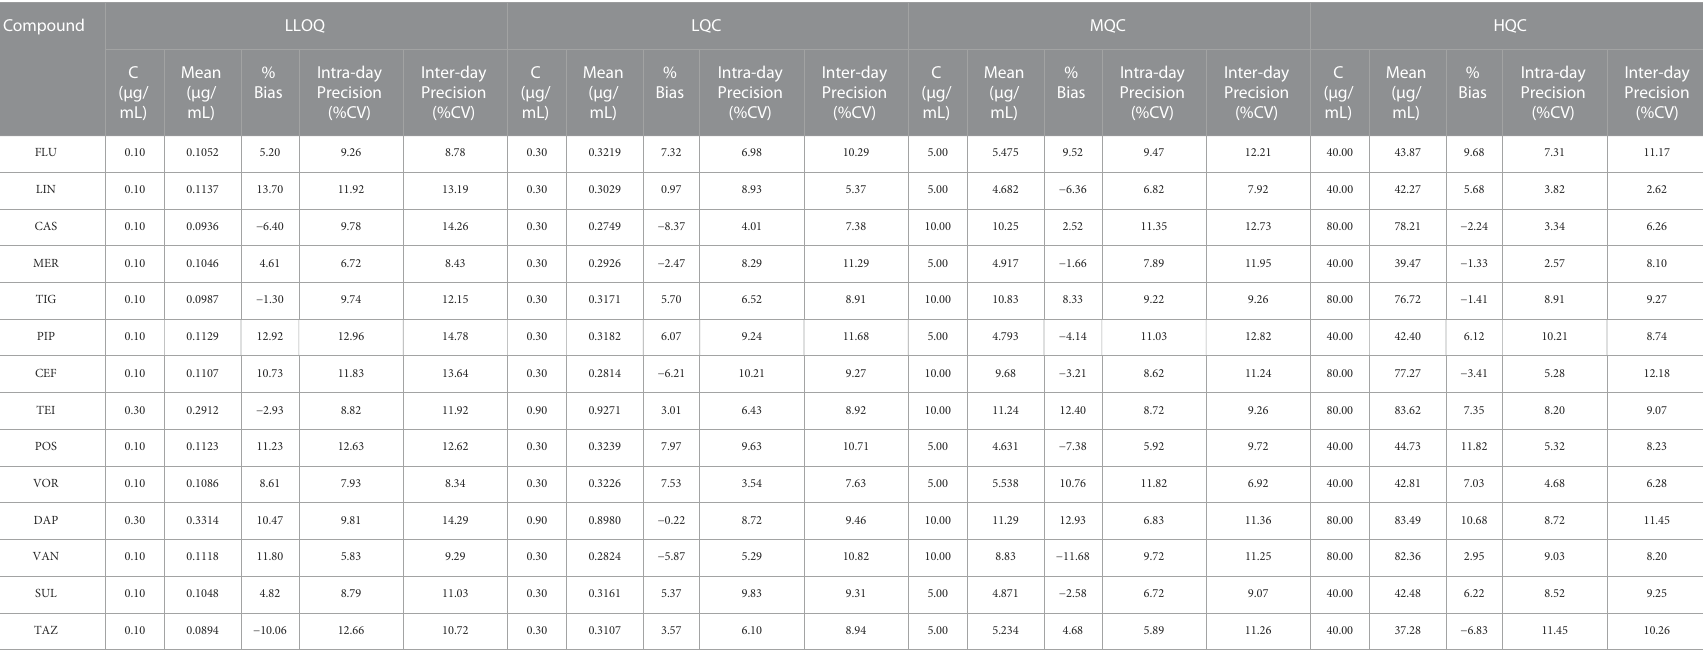
TABLE 2 Accuracy and precision of the developed method. Compound